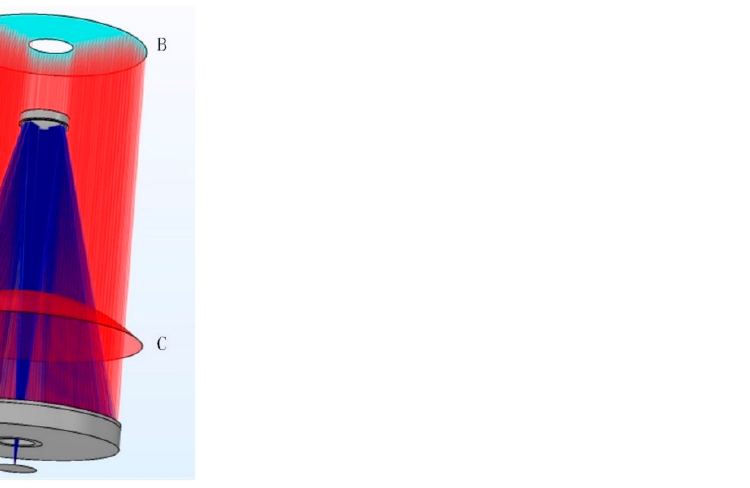
Figure 17. Optical path diagram of the Cassegrain system. A: The ideal image plane; B: The outgoing surface of light; C: The Gaussian reference sphere. Table 4. Wavefront aberration coefficients of the initial and optimized systems in the vertical optical axis.